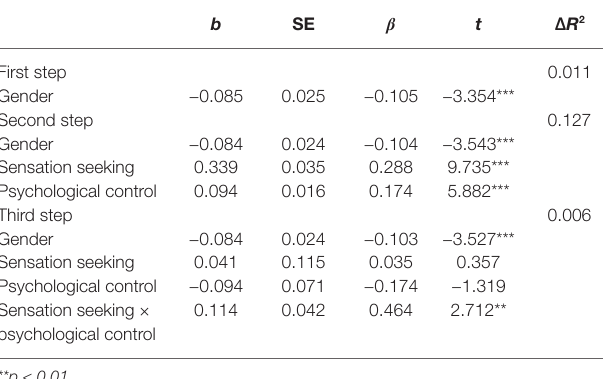
TABLE 3 | The relationship between sensation seeking and the use of tobacco and alcohol: the regulation of psychological control.